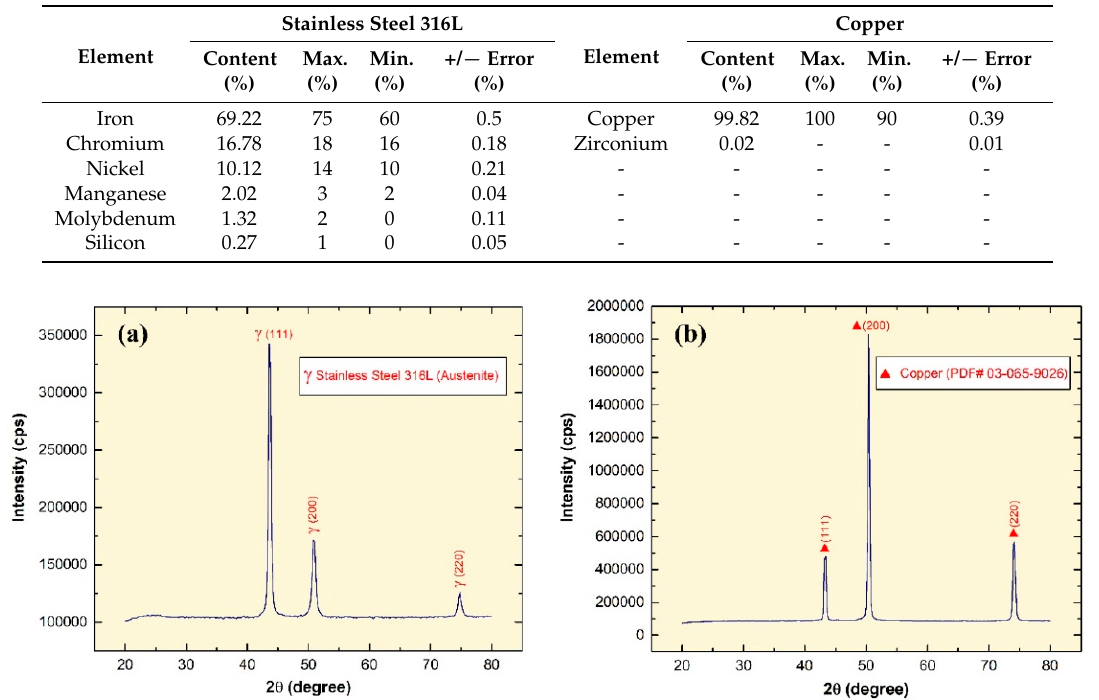
Table 1. Averaged XRF elemental analysis of SS 316L and Cu substrates.